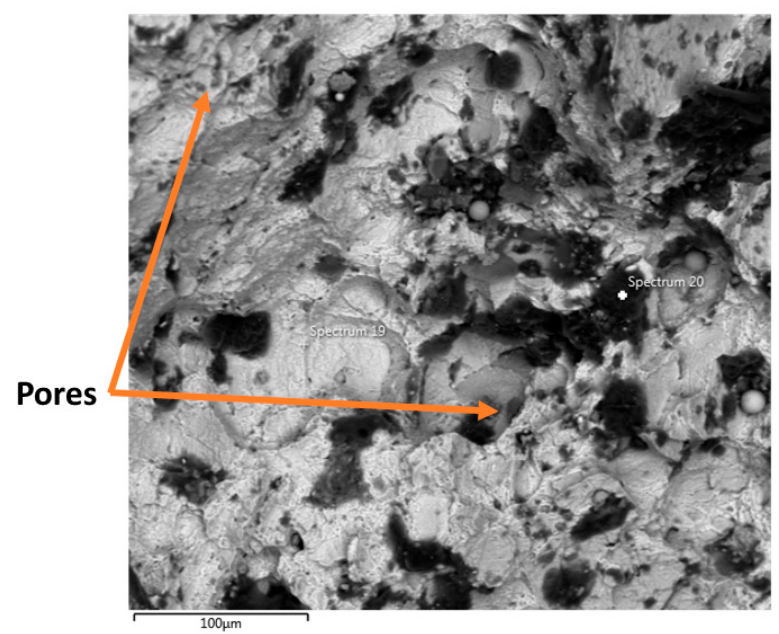
Figure 7. Fractograph of weld at a laser power of 2.8 kW and welding speed of 3 m/min.